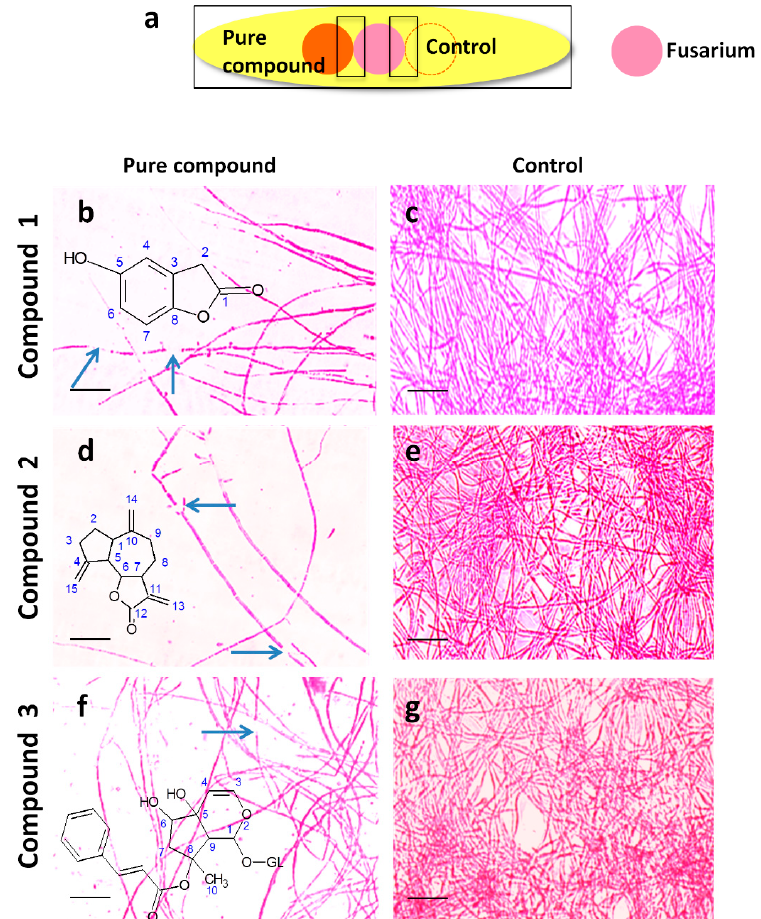
Figure 5. The effects of the purified endophyte-derived anti-fungal compounds on F. graminearum in vitro using neutral red staining. ( a ) Cartoon of the experimental methodology used to examine the in vitro interactions between F. graminearum (pink) and each compound (orange) or the buffer control (respective compound solvent). Microscope slides were pre-coated with PDA and incubated for 24 h. F. graminearum hyphae were then stained with neutral red. Shown are representative microscope slide pictures ( n = 3) of the interactions of F. graminearum with: ( b ) 5-hydroxy benzofuranone (5 mg/mL) compared to ( c ) the buffer control; ( d ) dehydrocostus lactone (5 mg/mL) compared to ( e ) the buffer control; ( f ) harpagoside (5 mg/mL) compared to ( g ) the buffer control. The blue arrows point to areas of apparent breakage of F. graminearum hyphae. Each scale bar equals 25 µm.